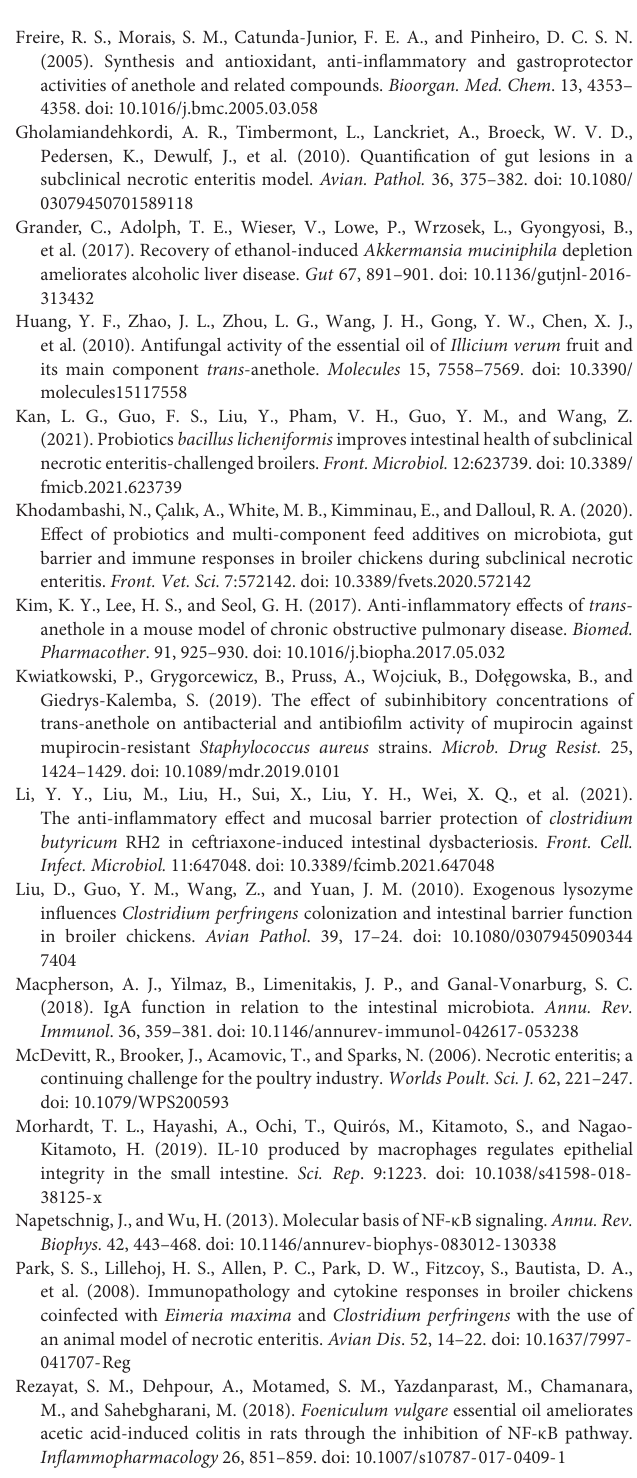
and NE + TA600 groups (B) . Welch’s t -test was conducted to determine the significant difference among the groups. Significant difference among the groups was declared at P < 0.05. CON, control group; NE + TA400, NE birds supplemented with 400 mg/kg of TA; NE + TA600, NE birds supplemented with 600 mg/kg of